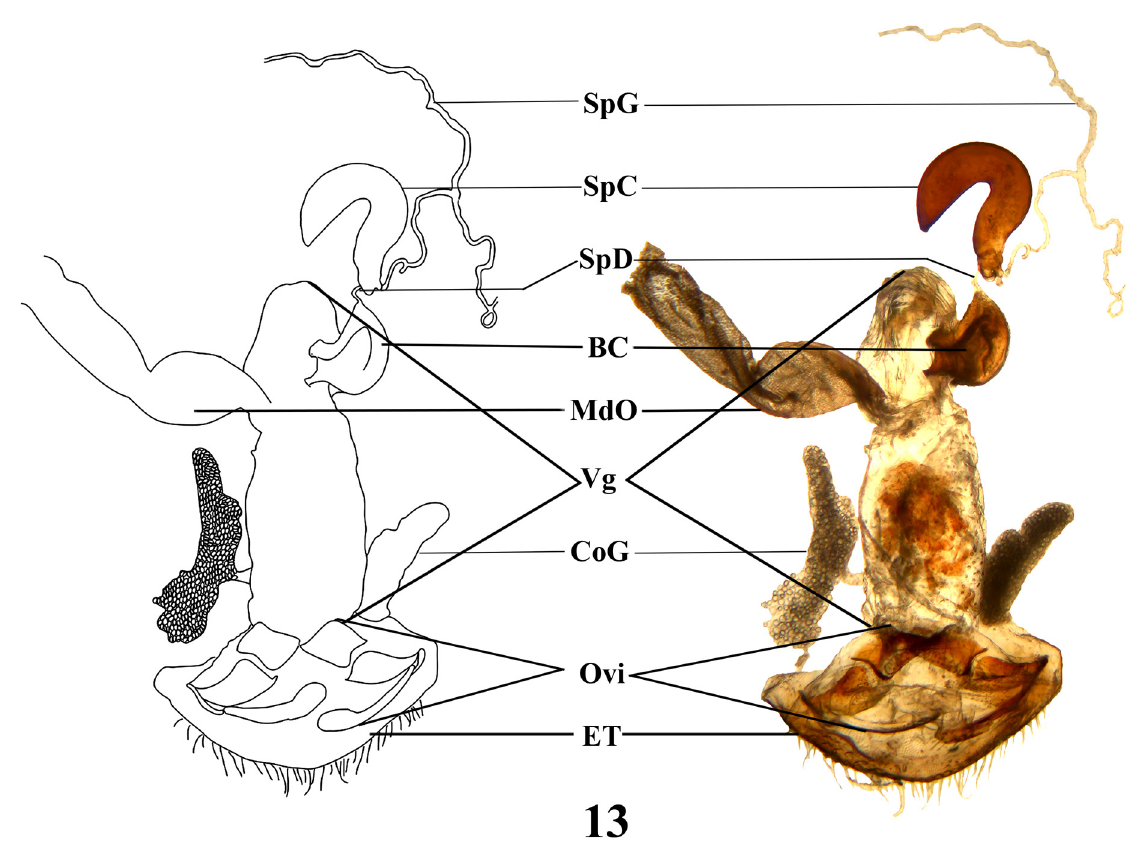
Fig 13. Female genitalia of Fidia kanaraensis (Jacoby, 1895) comb. nov. along with line diagram. Abbreviations: BC = bursa copulatrix; CoG = collateral gland; ET = eighth tergite; mdo = median oviduct; ovi = ovipositor; SpC = spermathecal capsule; SpD = spermathecal duct; SpG = spermathecal gland; Vg =